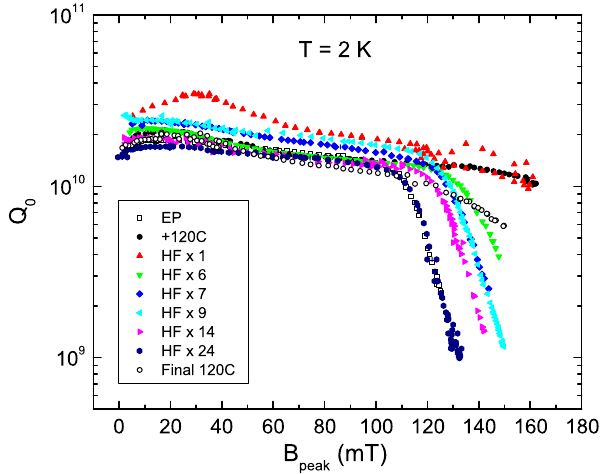
FIG. 3. Cavity rf test results after multiple HF rinse cycles for the electropolished cavity TE1ACC005. No field emission was present except for the final 120 (cid:1) C test.